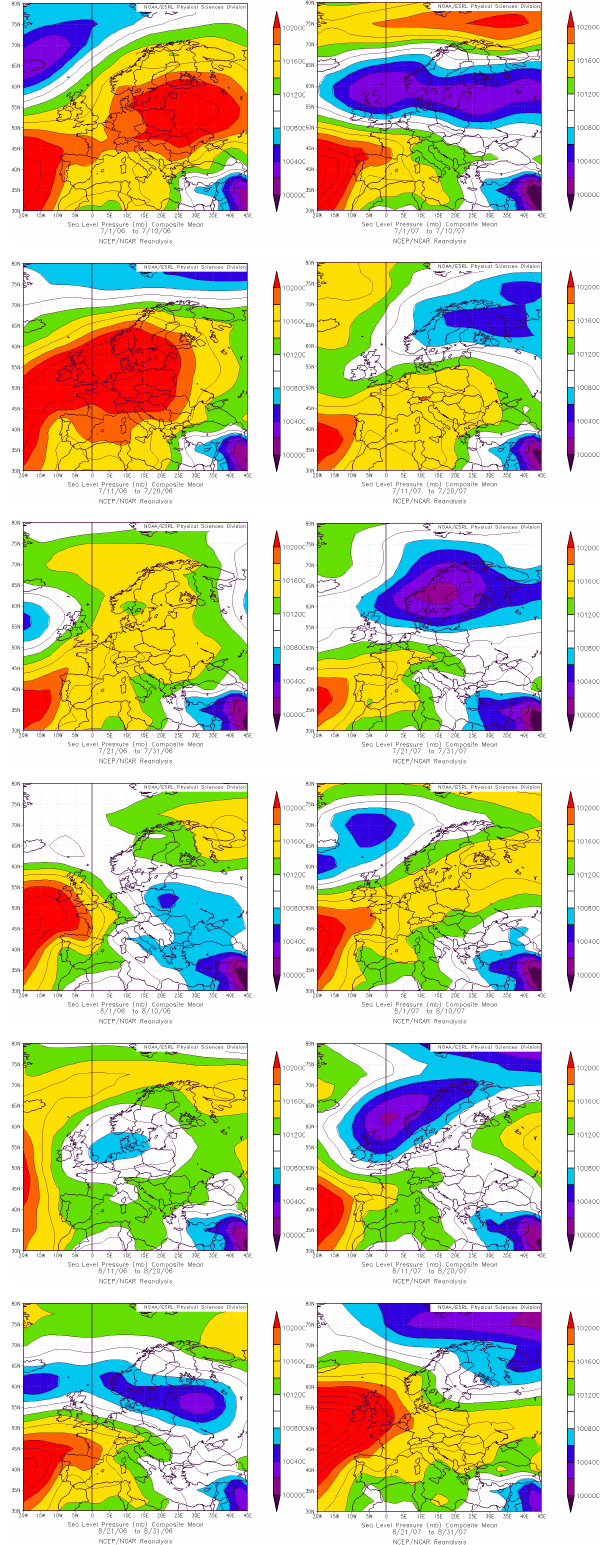
Fig. 17. 10 days SLP composite for July–August 2006 (left panel) and 2007 (right